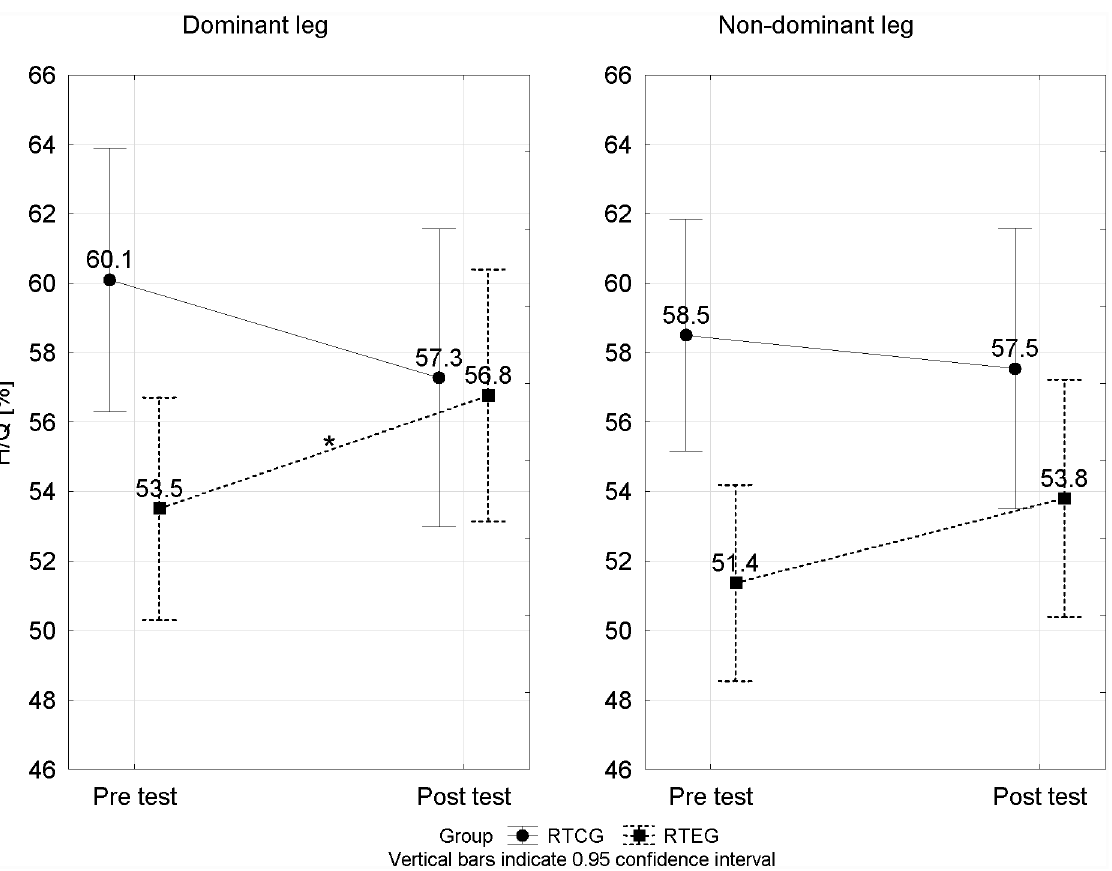
Fig 1. Comparison of changes in the H/Q ratio between the pre- and post-tests in two Training Resistance Groups. p < 0.05 * significant differences from pre- to